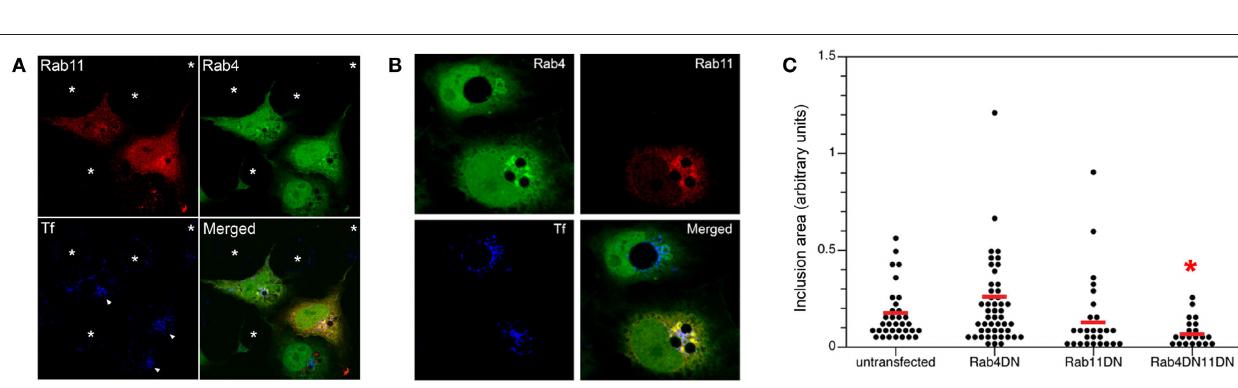
Figure 7 | Co-expression of dominant-negative constructs of rab4 and rab11 gTPases causes retention of Tf and reduces chlamydial inclusion growth. Cells were transfected with dominant-negative (DN) constructs of Rab4 or Rab11 either individually or in conjunction. (A) Transfected cells were